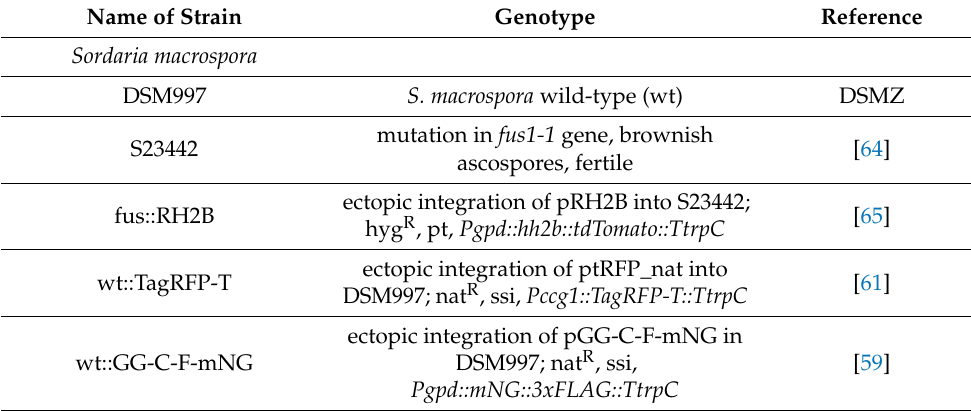
Table 1. Strains used in this